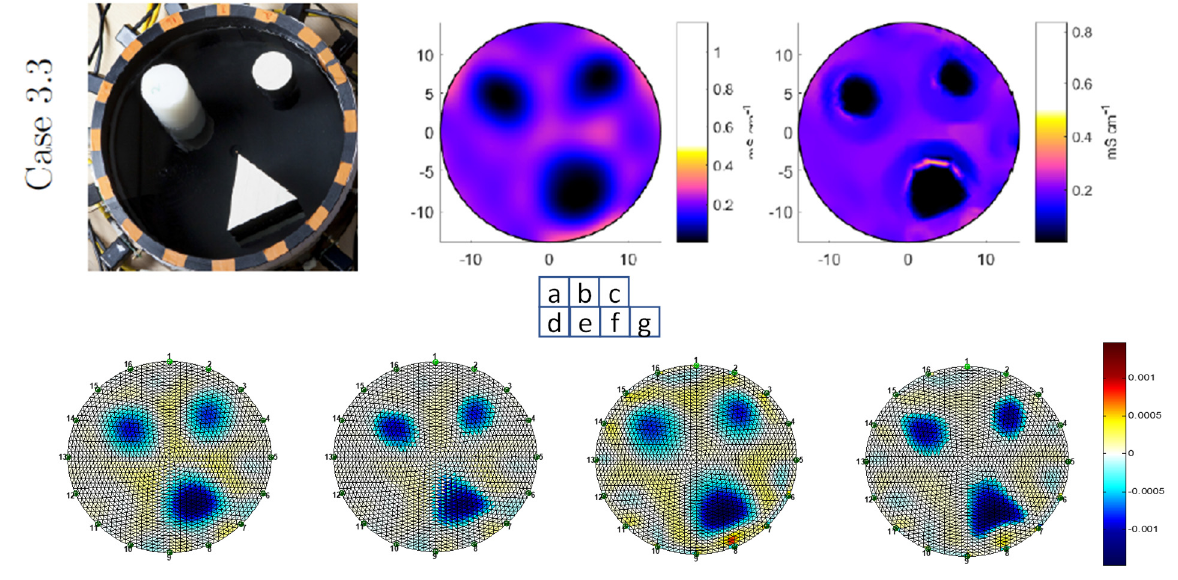
Fig.10: Reconstructions for open data. (a)(b)(c) case3.3 actual photograph with reconstructed images in open EIT data. (d)(e) Reconstructed images without and with DeTER using NOSER prior. (f)(g) Reconstructed images without and with DeTER using Tikhonov prior.